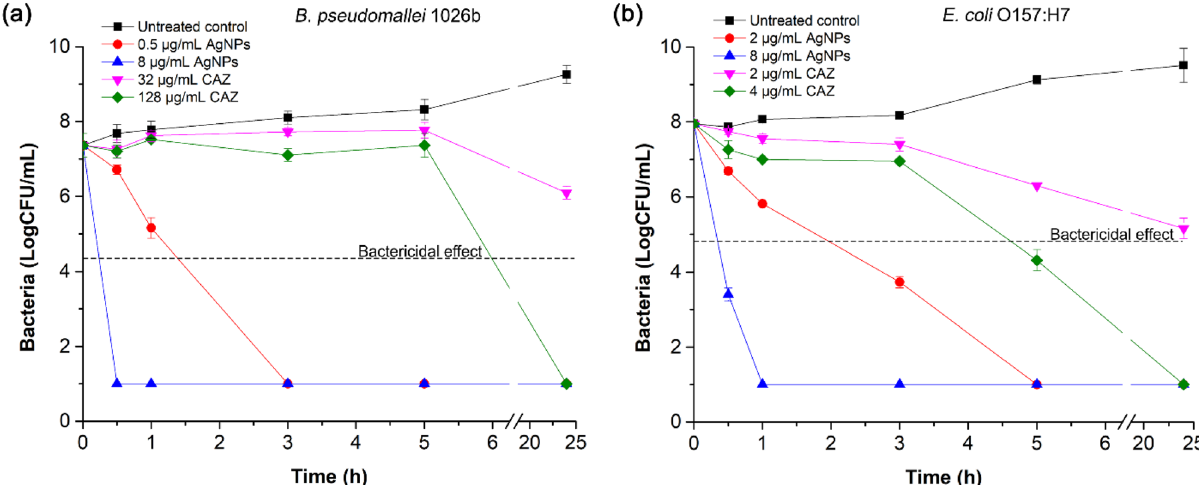
Figure 3. Killing time of antimicrobial agents (andro-AgNPs and ceftazidime (CAZ) antibiotic) against B. pseudomallei 1026b ( a ) and E. coli O157:H7 ( b ). The bacteria were incubated with antimicrobial agents at the concentration of MIC and MBC for 24 h (for andro-AgNPs, MIC and MBC are 0.5 and 8 µg/mL for B. pseudomallei 1026b, and 2 and 8 µg/mL for E. coli O157:H7. For CAZ, MIC and MBC are 32 and 128 µg/mL for B. pseudomallei 1026b, and 2 and 4 µg/mL for E. coli O157:H7). At time points of 0, 0.5, 1, 3, 5, and 24 h, 50 µL of each sample was taken for serial dilution and plate count. The bactericidal effect was defined as ≥ 3 log10 reduction compared to an untreated control. Data represent mean value ± SD (error bar) from two independent experiments in triplicate (n =